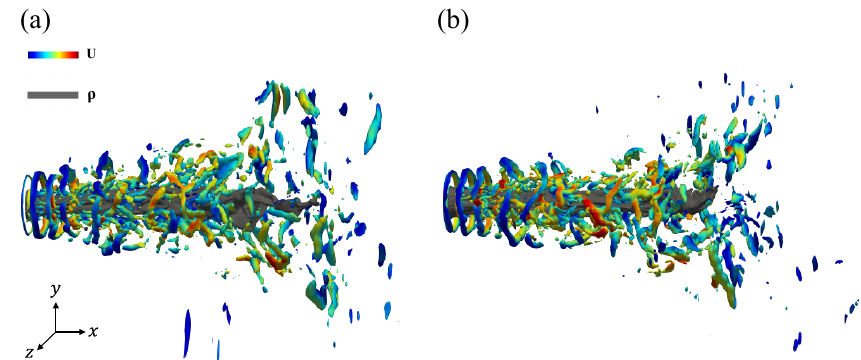
Figure 6. Instantaneous calculation results in the LES. The iso-surface of the Q-vortex (4 × 10 8 s − 1 ) colored by the axial velocity, and the iso-surface of the density (100 kg/m 3 ) for both LES cases: ( a ) Case 1 and ( b ) Case